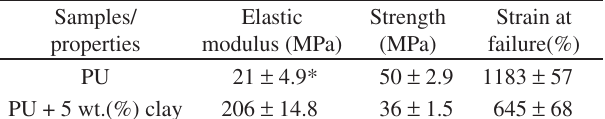
Table 2. Mechanical properties of polyurethane (PU) and polyurethane having clay nanoparticles. Samples/